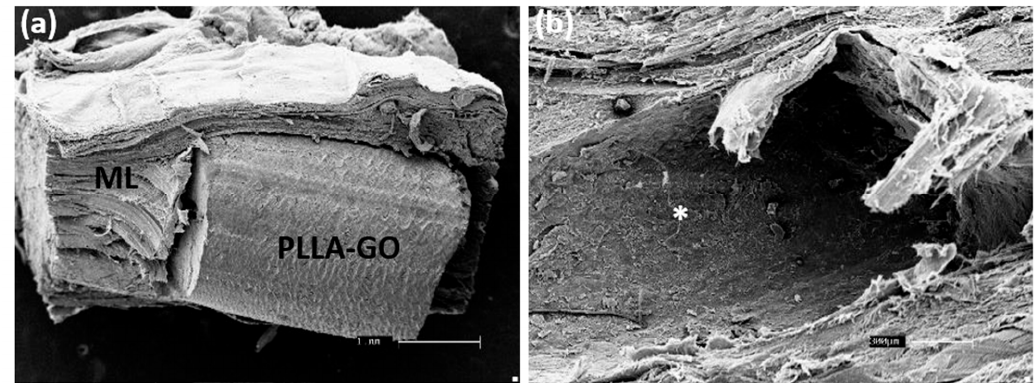
Figure 7. SEM of the muscle layer (ML) containing the polymer (PLLA-GO), bar: 1 µm, ( a ); focal local indicating the pol- ymer space after removing (*), scale bar: 300 µm ( b ).